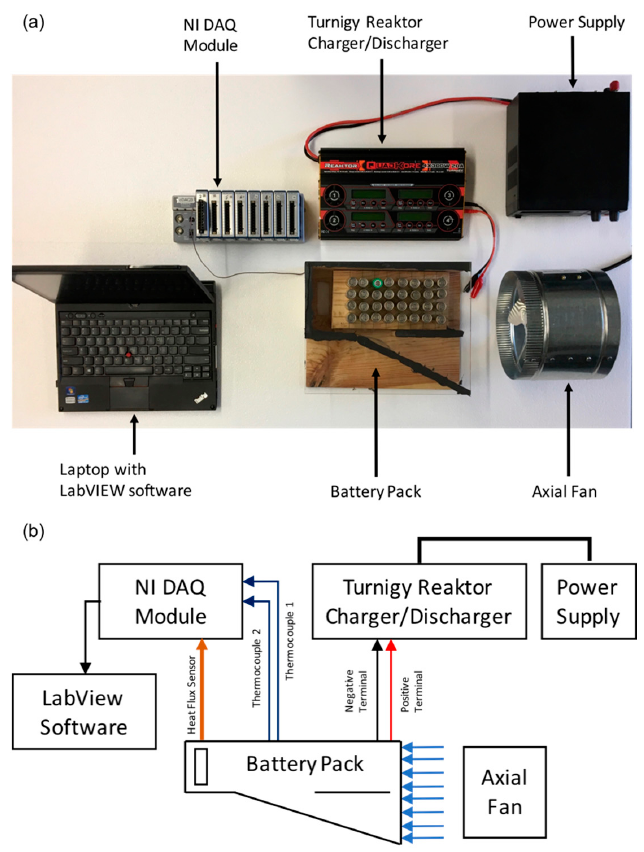
Figure 4. ( a ) Top view of the experimental setup and ( b ) schematic of the experimental setup. NI DAQ, National Instruments cDAQ-9178.